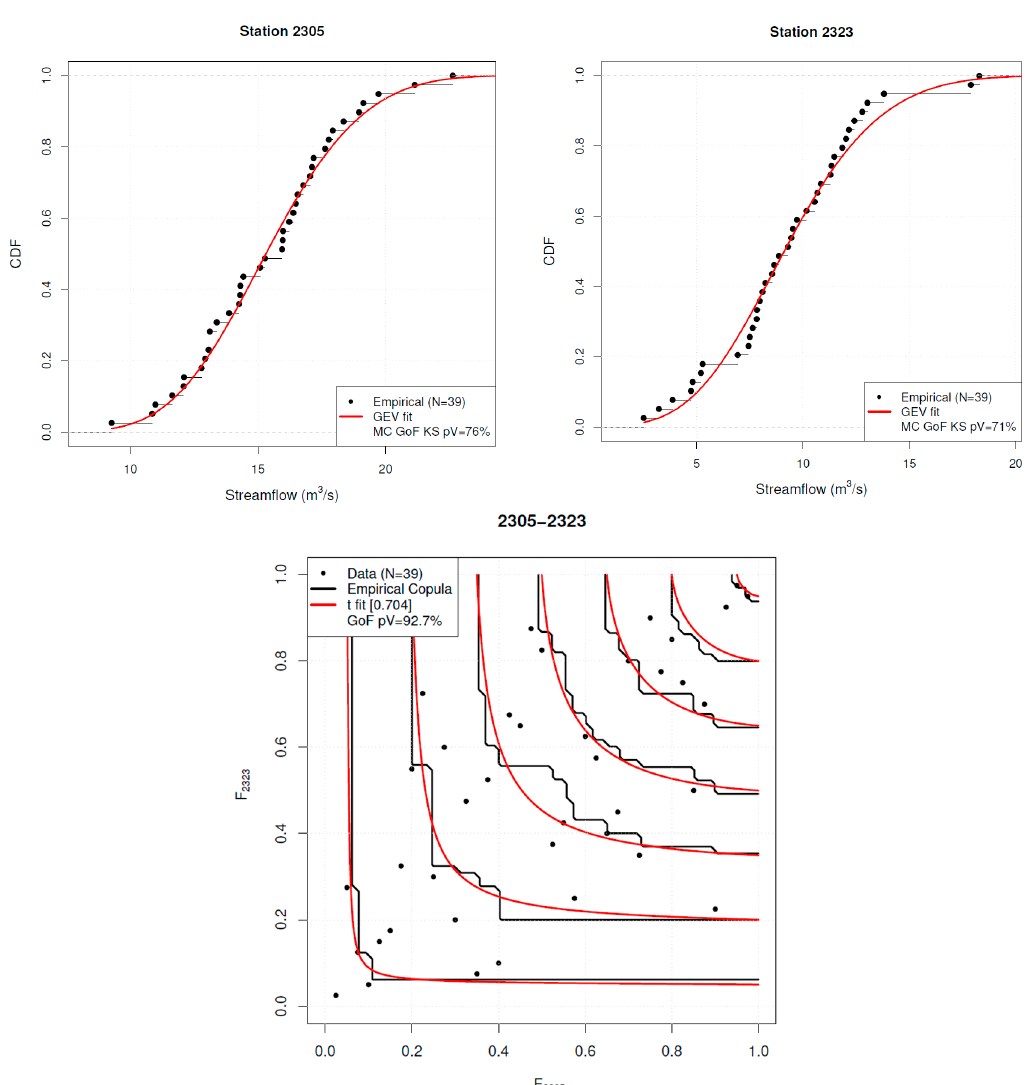
Figure 6. Middle Çoruh basin. ( Top row ) GEV fits of the 7-day low flow series in the middle Çoruh basin. Shown: the empirical CDF (black markers), the fitted CDF (red line), the sample size N and an approximate Monte Carlo Goodness-of-Fit test p -value of Kolmogorov–Smirnov type. ( Bottom row ) Copula fit. Shown: the pseudo-observations (markers), the empirical copula (black lines) and the fitted copula family (red lines). Additionally shown are the sample size N, an MLE estimate of the copula parameter, and an approximate Monte Carlo Goodness-of-Fit test p -value of Cramér-von Mises type.